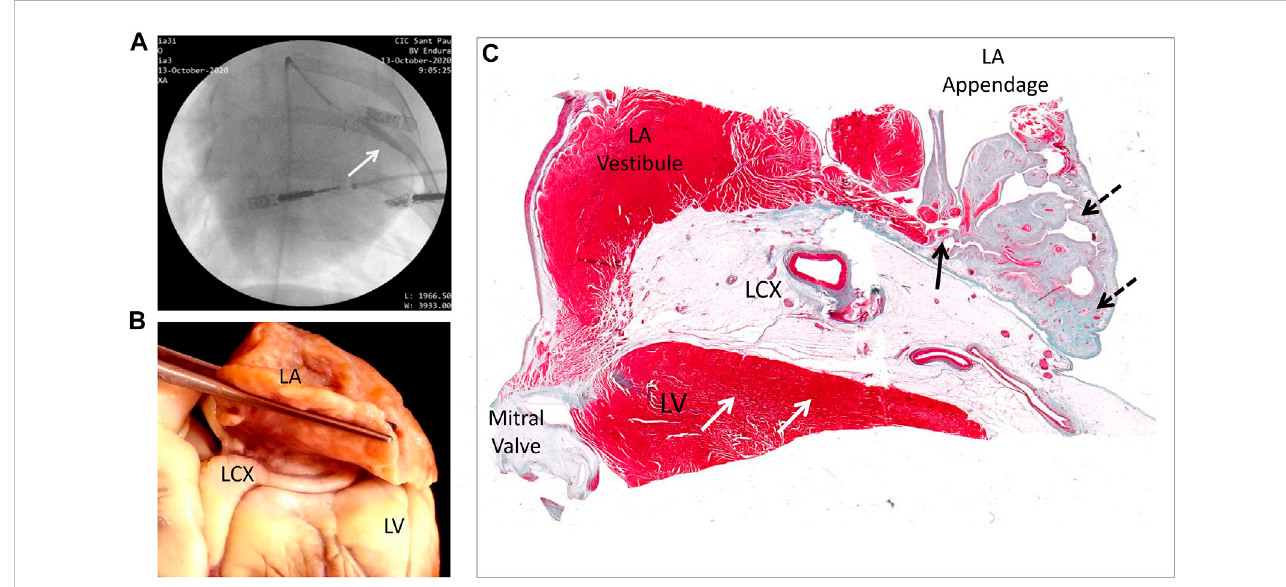
FIGURE 1 Illustration of the experimental procedure and study specimen preparations. (A) Fluoroscopic image of one studied pig showing the catheter balloon locatedintheproximalsegmentoftheLCXwhiledeployingthecoveredstent(whitearrow). (B) Photographshowingtheanatomicalrelationshipbetweenthe left ventricle (LV), left atrium (LA) and the left circum fl ex coronary artery (LCX) where the covered stent was deployed. (C) Microphotograph of a histological preparation (frontal section) showing both areas of infarct infarcted (dashed arrows) and non-infarcted areas (solid arrows) in the left atrial appendage with preserved left ventricular myocardium (white arrows) corresponding to the annular